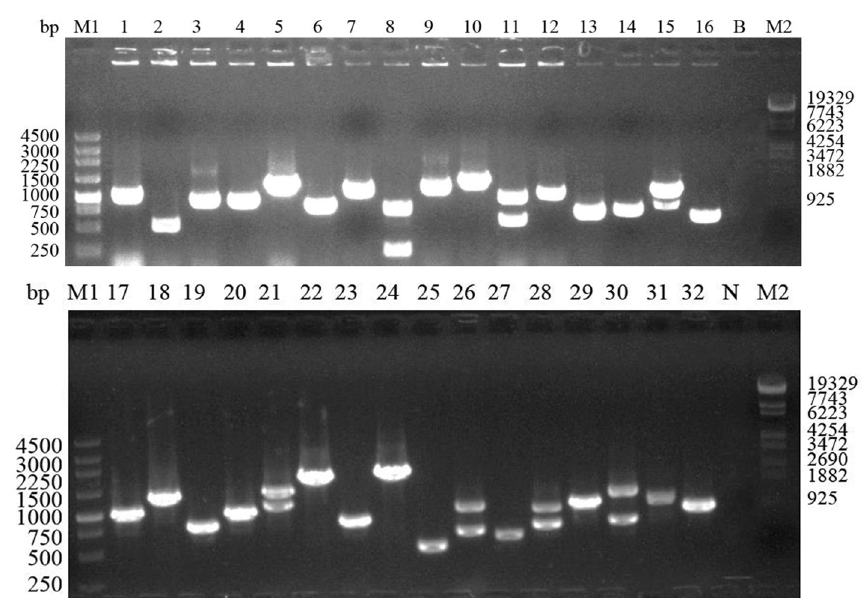
Figure 2. Analysis of the inserted fragment in chicken duodenal epithelial cell normalized cDNA library using PCR. M1: DL19329 marker; M2: DL4500 marker; 1 – 32: PCR analysis of 32 bacterial colonies; B: Blank control without template; N: Negative control of library